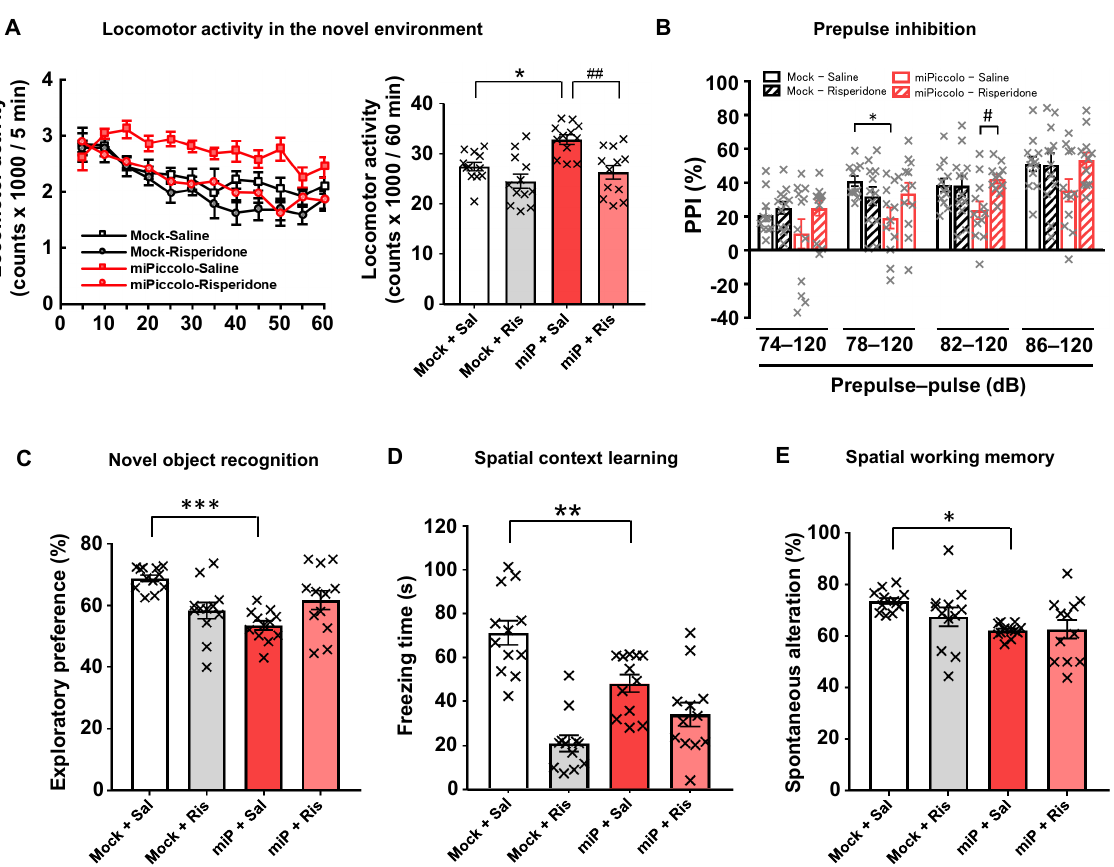
Figure 4. Behavioral analyses of miPiccolo mice. ( A ) The locomotor activity in a novel environment was measured every 5 min for 60 min (n = 12). * p < 0.05 vs. Mock-Saline, ## p < 0.01 vs. miPiccolo-Saline (one-way ANOVA followed by Tukey’s post-hoc test). ( B ) Prepulse inhibition (PPI) was measured by presenting a semi-random series of prepulse of various intensities (74, 78, 82, 86 decibels) paired with the acoustic startle stimulus (120 db) to the mice (n = 12). * p < 0.05 vs. Mock-Saline, # p < 0.05 vs. miPiccolo-Saline (one-way ANOVA followed by Tukey’s post-hoc test). ( C ) An indication of the time spent approaching the novel object in the trial phase of the novel object recognition test. Risperidone was administered 30 min before the acquisition and test phase (n = 12). *** p < 0.001 vs. Mock (one-way ANOVA followed by Tukey’s post-hoc test). ( D ) Spatial context learning was assessed based on the freezing time at 24 h after a conditioning session. Risperidone